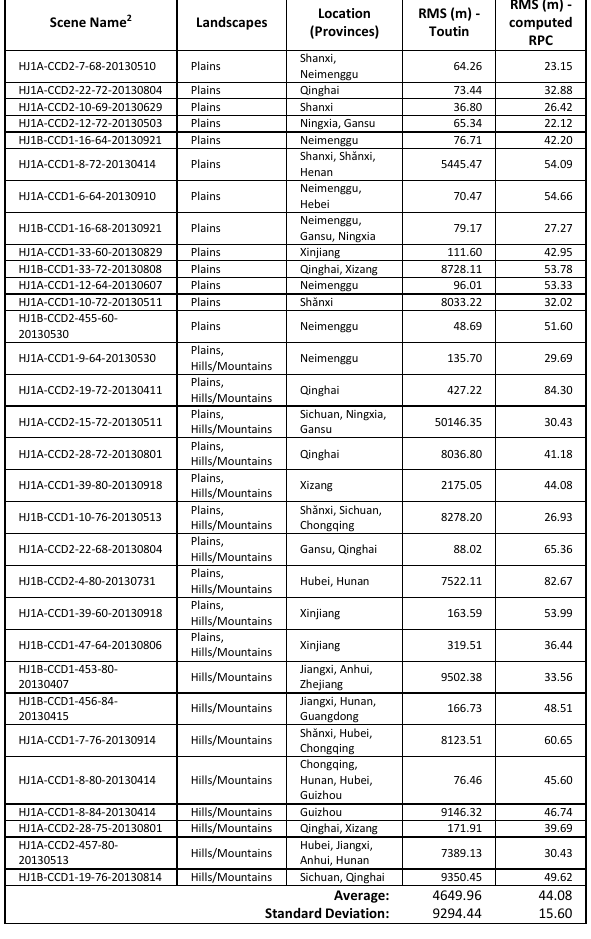
Table 1 HJ-1 A/B testing scenes and accuracy results